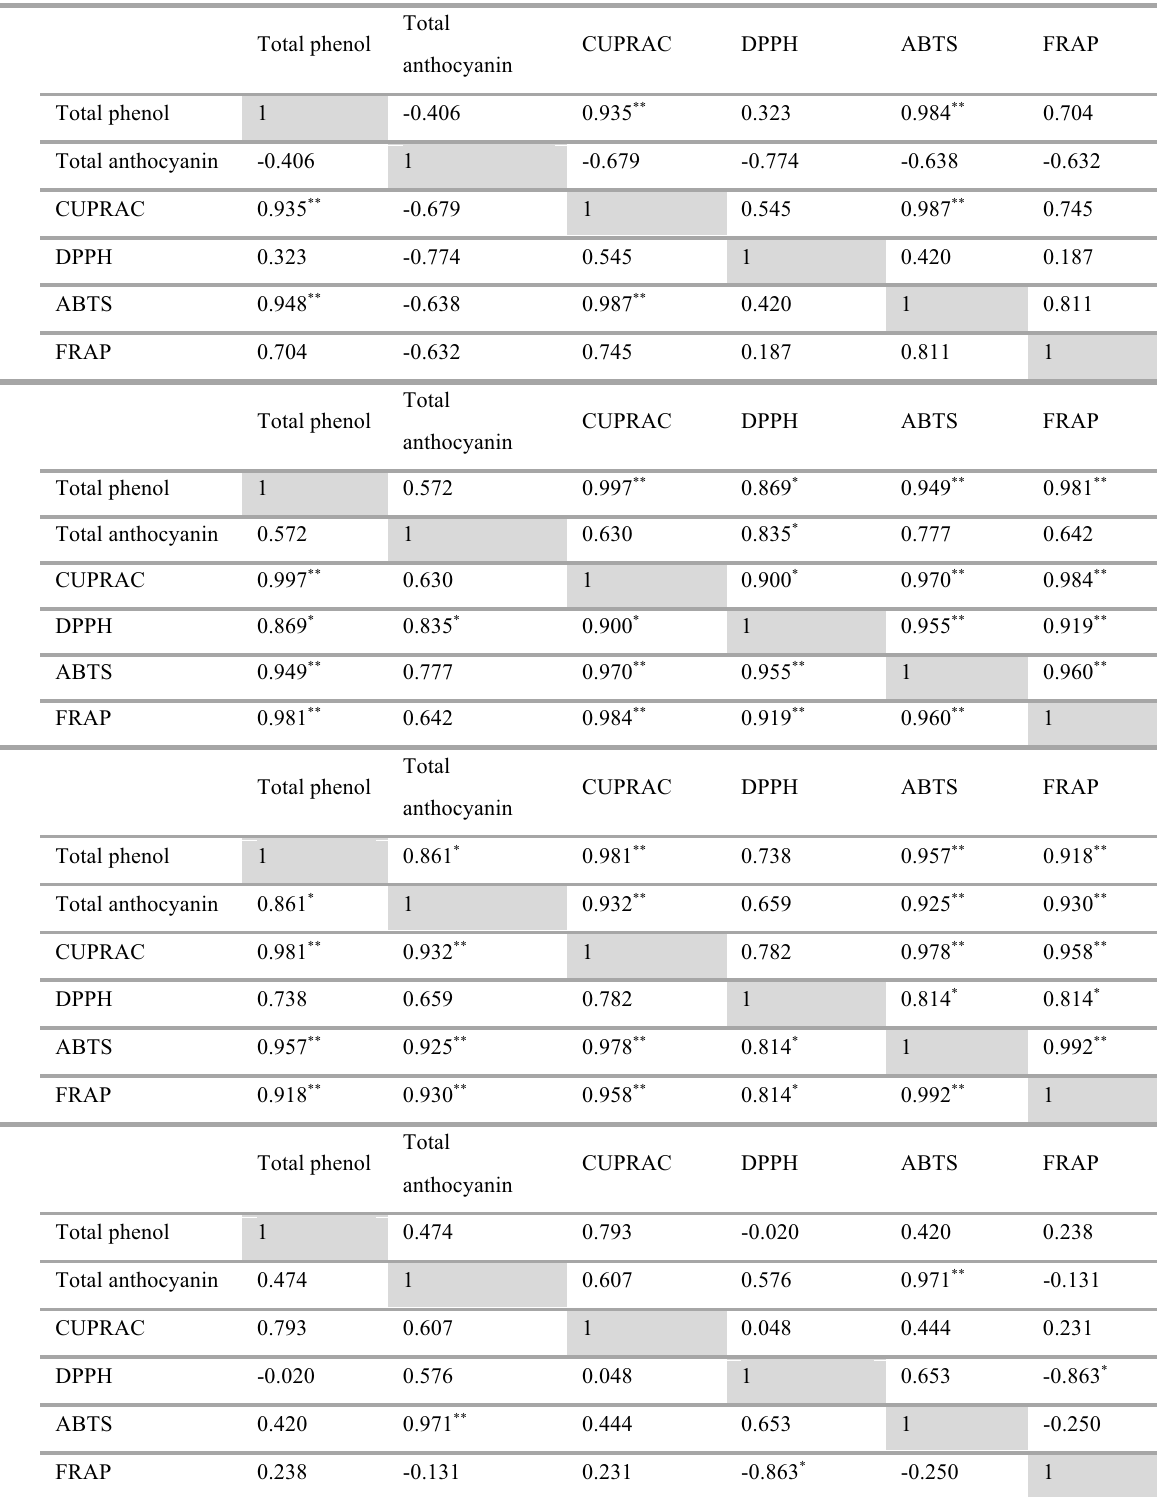
Table 5. Correlation coefficient of total phenolic content. total anthocyanin content and antioxidant capacity of fresh and dried Vac. myrtillus fruit and leaf